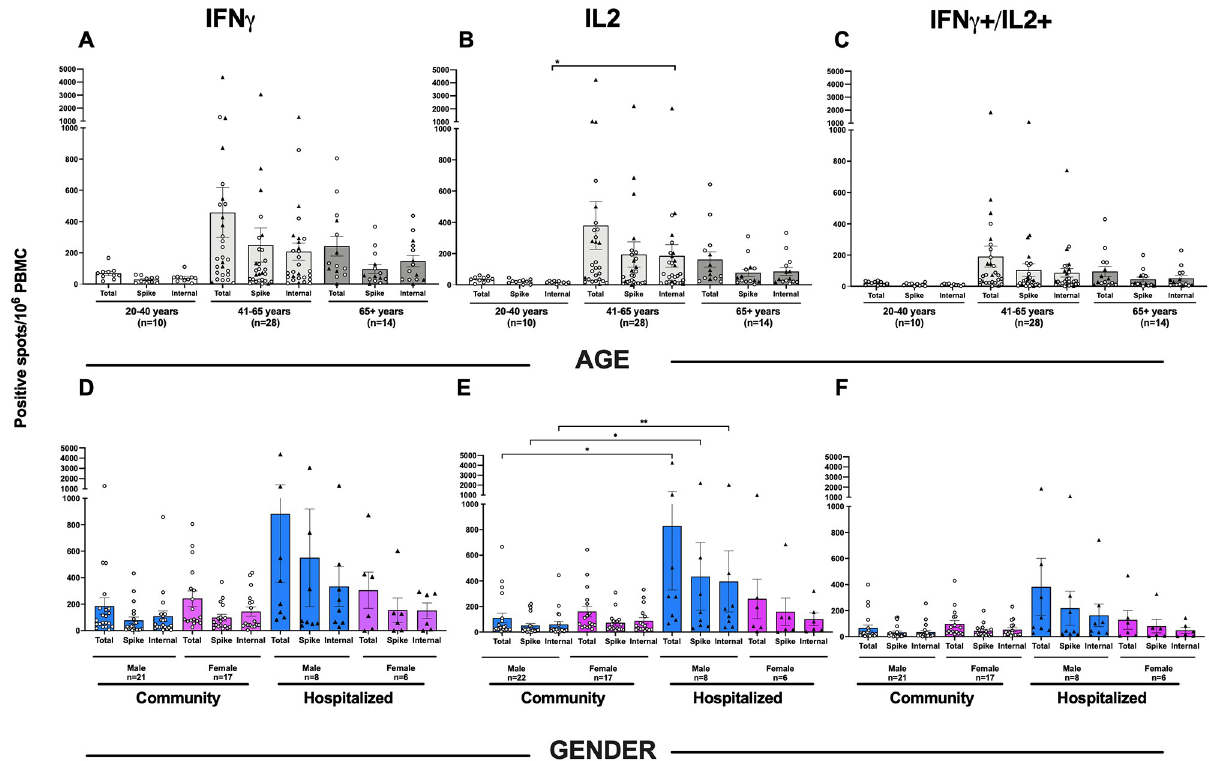
Fig 5. Influence of age and gender on SARS CoV-2 specific T cells. The SARS-CoV-2 specific IFN- γ responses in peripheral blood mononuclear cells (PBMC) were determined by IFN- γ + (A,D), IL-2 + (B,E), and IFN- γ + + IL-2 + (C,F), in FluroSPOT in community and hospitalized patients who were SARS-CoV-2 confirmed, rt-PCR positive. The results are plotted according to age (A-C) and gender (D-F). Each symbol represents the SARS-CoV-2 IFN- γ /IL-2 response (spot forming units (SFU) per 1 × 10 6 cells) after stimulation with virus spike antigen. The circle symbol represents community dwelling patients, and the triangle represents the hospitalized patients. The horizontal bars represent the mean response for each time point ± standard error of the mean. Statistical significance was determined by the non-parametric Kruskal-Wallis multiple comparisons test ( � = P < 0.05, �� = P < 0.005).